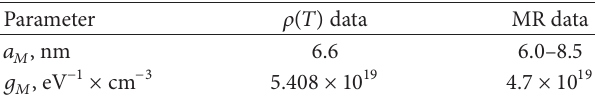
Table 1: Parameters of the Mott-type VRH obtained within two different